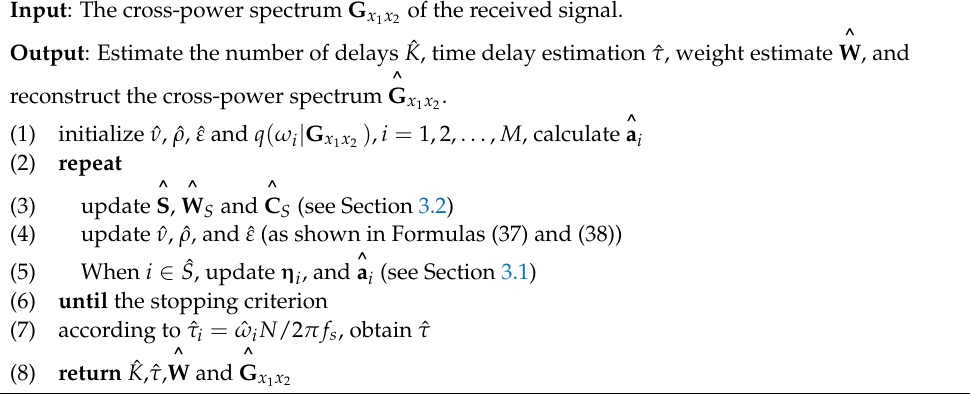
Algorithm 1. Description of the VATDE algorithm.